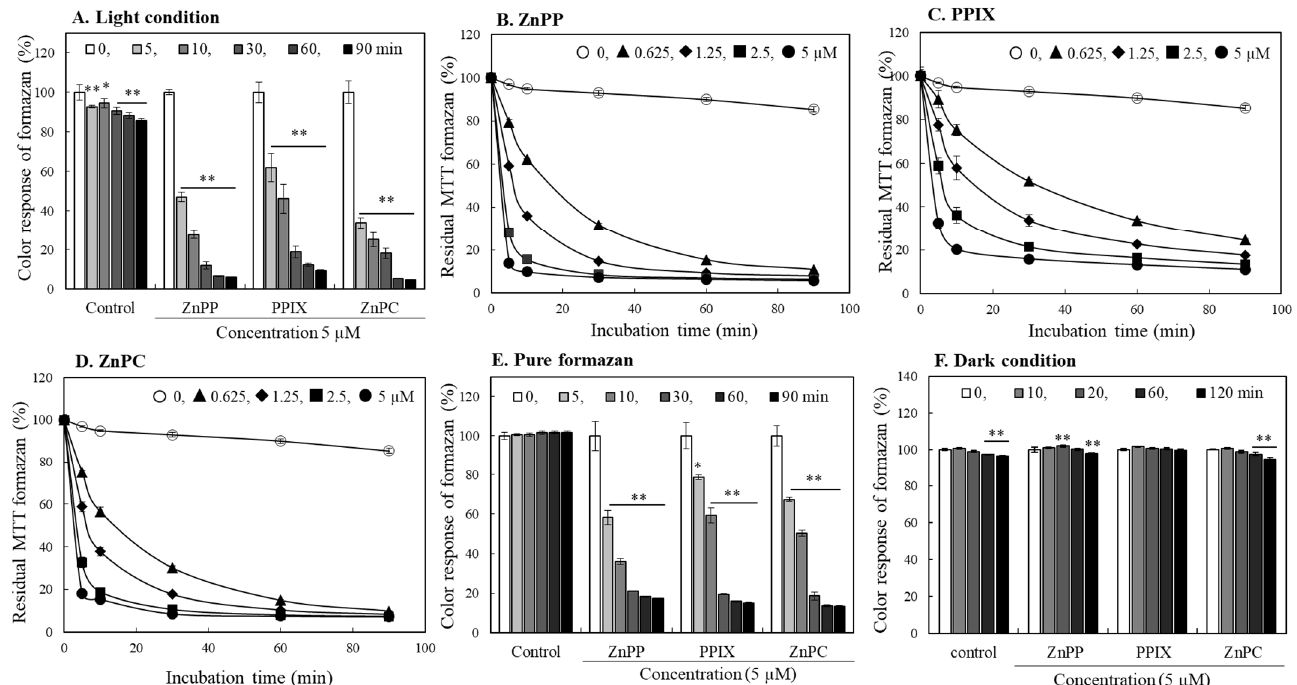
Figure 5. Effects of porphyrin derivatives on color stability of MTT formazan under light or dark conditions. MTT formazan produced by cells was dissolved in DMSO and was mixed with each porphyrin (5 μ M). The mixture was irradiated at room temperature under a fluorescence light, and changes of color intensity of MTT formazan were analyzed at 550 nm during 90 min ( A ). Effects of ZnPP ( B ), PPIX ( C ), and ZnPC ( D ) on the color stability of MTT formazan produced by cells or pure formazan ( E ) were analyzed at different time points under light. Effects of each porphyrin (5 μ M) on color stability of MTT formazan were also measured in a dark condition ( F ). Each value represents the mean ± S.D. ( n = 8). *, **, Significantly different from control according to Student’s t ‐ test (*, p < 0.01; **, p < 0.001).